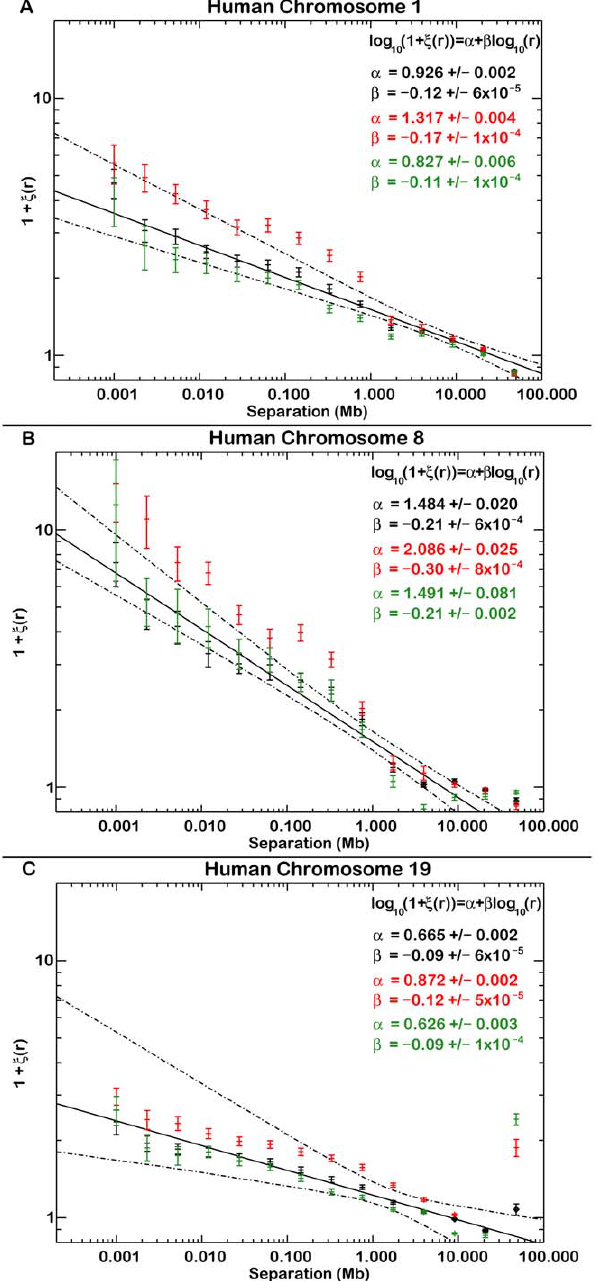
Figure 2. The Two Point Correlation Functions of CGI in Chromosomes 1, 8 and 19. The vertical axis shows value of the two- point correlation function, estimated using the bootstrap mean 1 z ^ jj ( r ), (see methods), and error bars are + ^ ss SE . The expectation in the absence of clustering is 1 z ^ jj ( r ) ~ 1 . CGI using the Takai and Jones (2002) algorithm are shown in black, as are the best-fit power law models. Dotted lines show an approximate 3 s confidence intervals derived from a Monte Carlo based on the bootstrap estimate of j and our estimate of its variance (see Methods). Also shown in red (green) are the TPCF for the CGI given by Irizarry et al [56] (Illingworth et al [40]) and the associated regression coefficients also in red (green). Remaining chromosomes can be found in Text